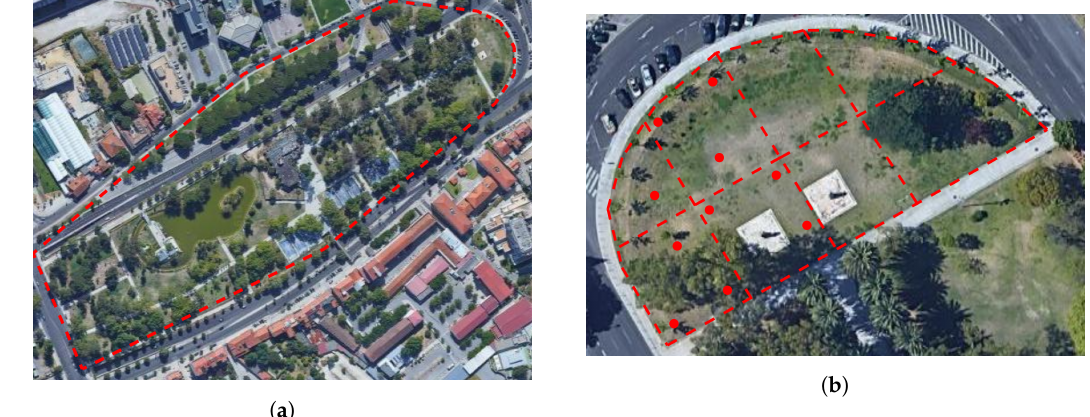
Figure 4. ( a ) Satellite Image of the Garden; ( b ) Irrigation zones and sensor